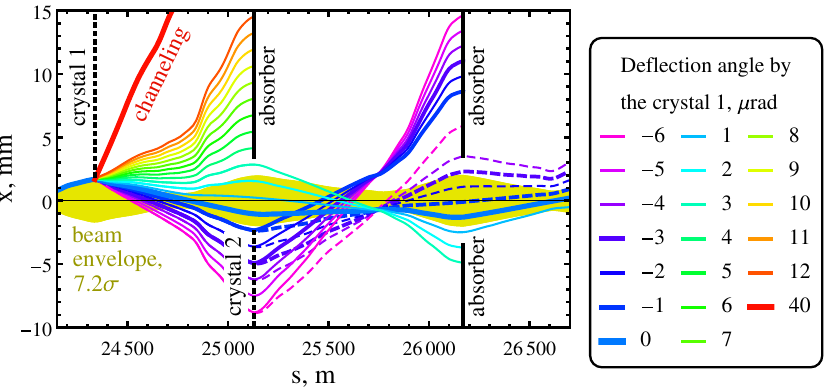
FIG. 1. Double crystal-based collimation system. Beam trajectories for different deflection angles by the crystal 1 are simulated in the betatron cleaning area of the FCC [17], taking into account only betatron oscillations. The crystal 1, crystal 2 and the absorbers are placed at 7 . 2 σ , 9 σ and 12 . 6 σ respectively. The particles, passed through the crystal 2, are assumed to be deflected by - 5 μ rad for solid lines and 0 μ rad for the dashed ones. Bold curves illustrate the trajectories of non-deflected particle, of channeled particles and particles deflected by 1 and 3 μ rad, being the typical angles of particle deflection by volume reflection (VR) and multiple volume reflection in one bent crystal (MVROC)